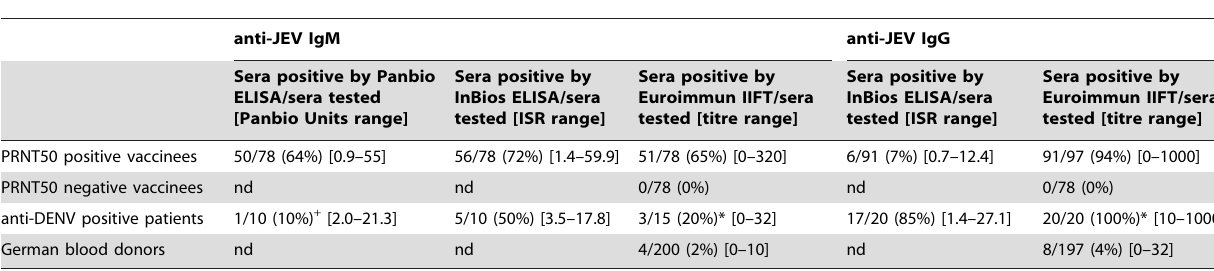
Table 1. Reactivity of IgM and IgG antibodies directed against JEV in ELISA and IIFT.